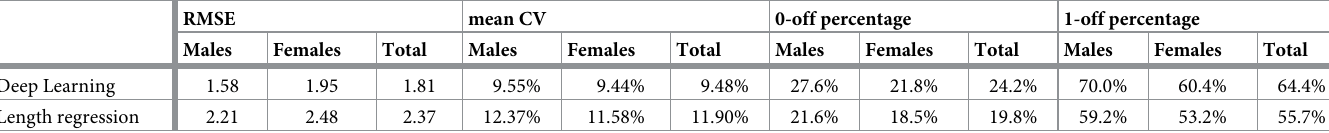
Table 2. Summary of test results. Summary of overall test results for age estimation using deep learning and linear length-based regression.